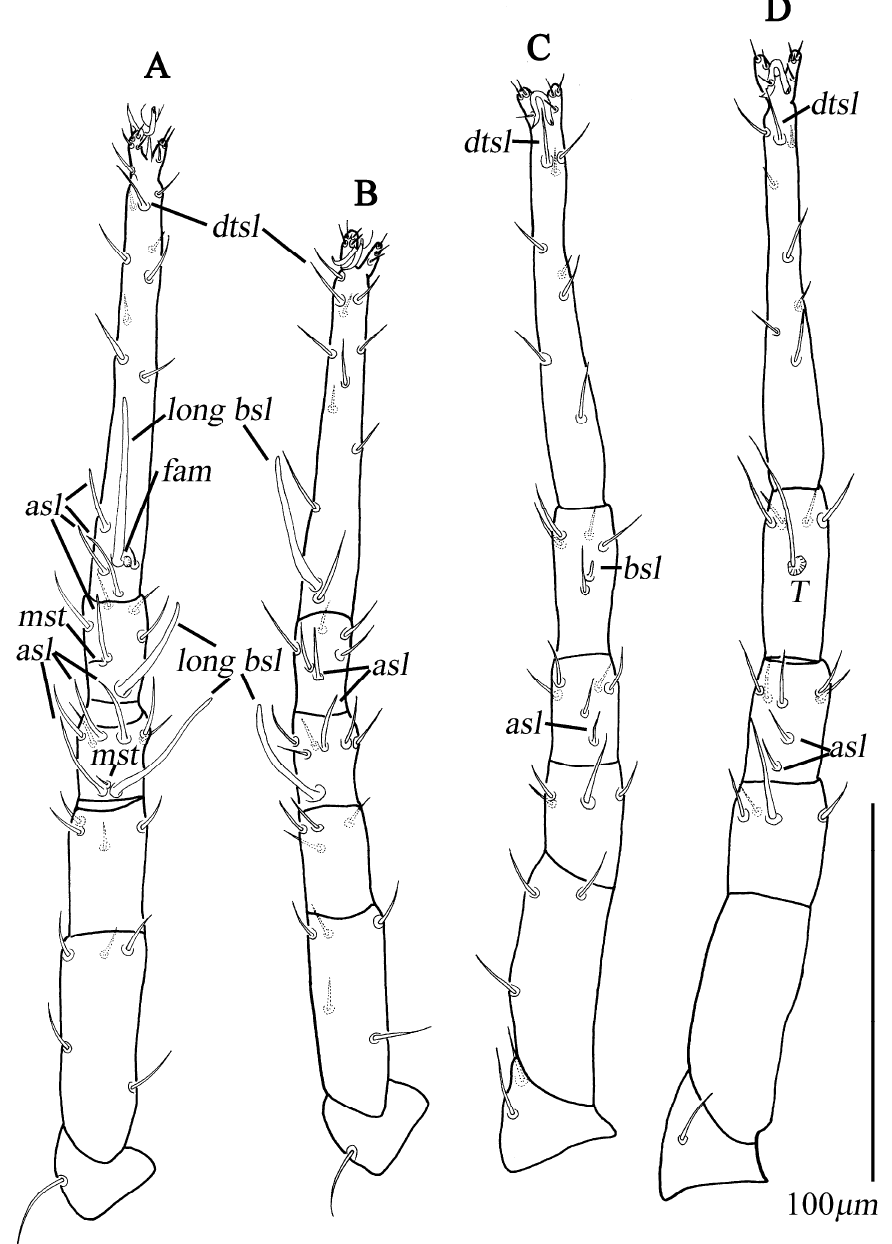
Figure 21. Brevicaudus trapezoides sp. nov. (Male). ( A – D )—Legs I–IV, respectively. Scale bar = 100 µm.